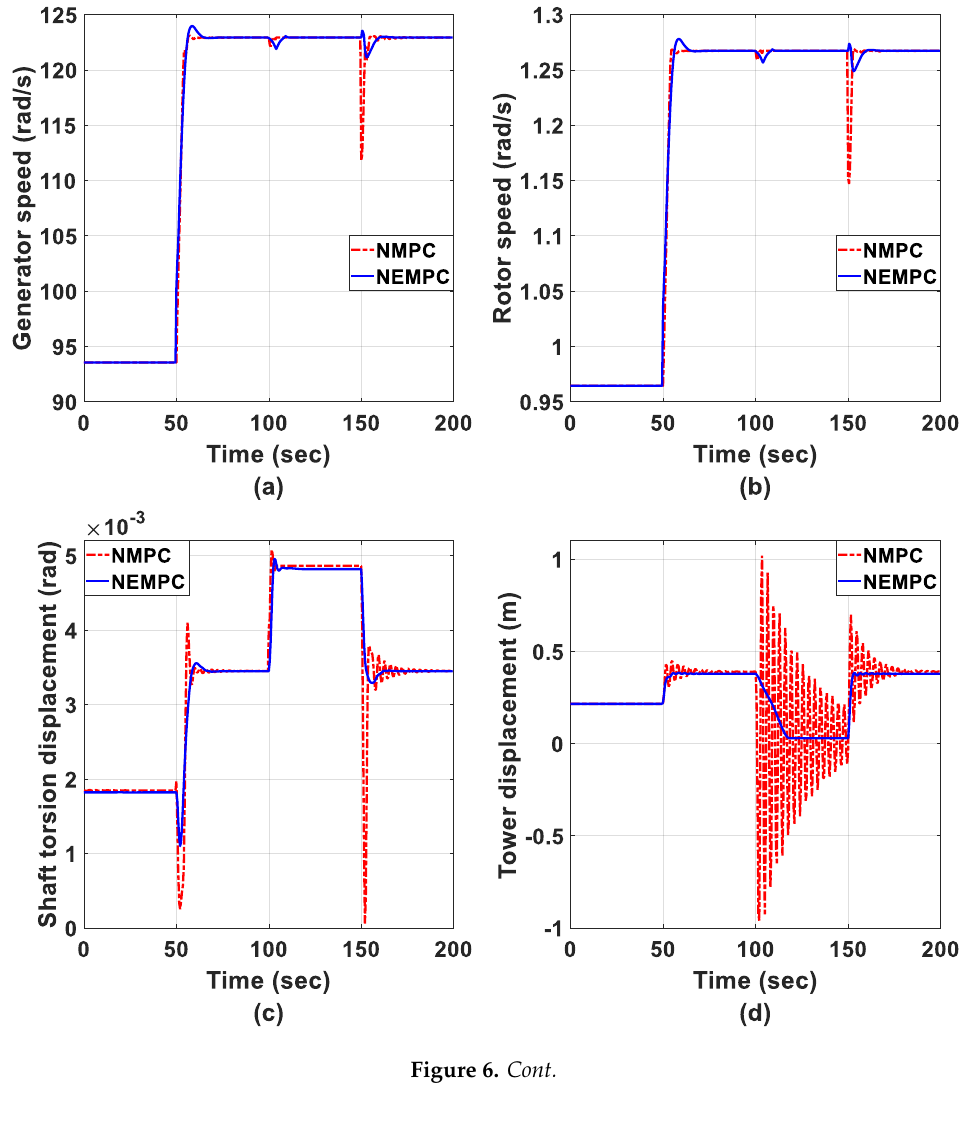
Figure 5. Gradient wind speed.